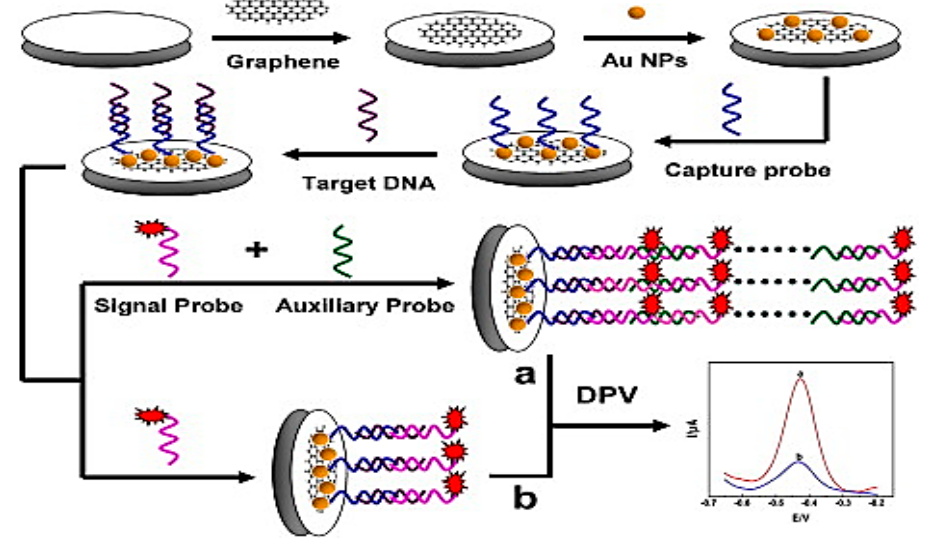
Figure 10. Schematic representation of the fabrication procedure of the DNA biosensor. ( a ) DPV cures from the super-sandwich biosensor; ( b ) DPV cures from the sandwich biosensor. Adapted from [167], with permission from ©2015 Elsevier.